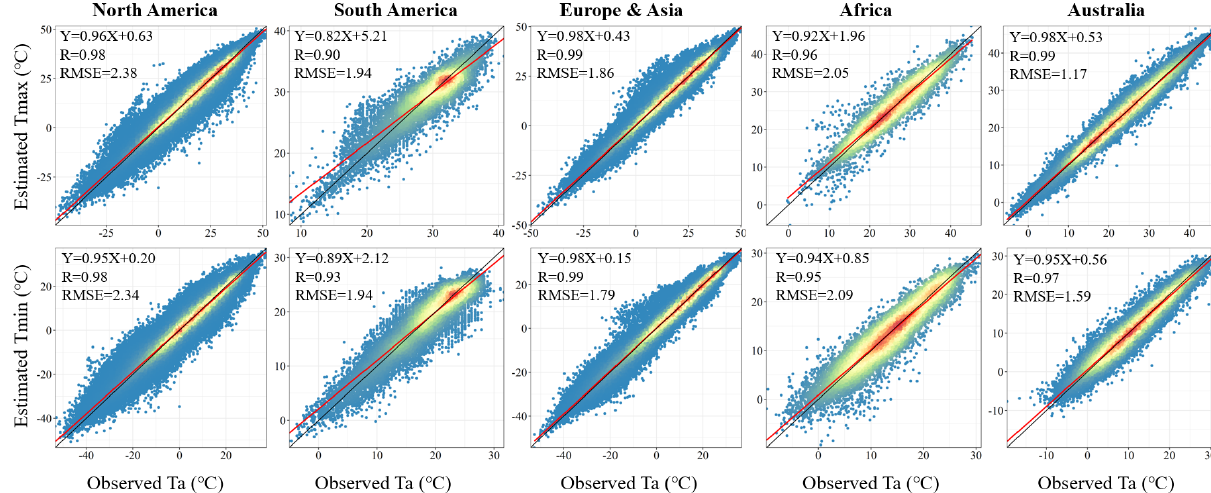
Figure 3. Scatter plots between estimated and observed T a in five regions in the year 2010. Each point represents the estimated and observed T a ( T max or T min ) on a specific day at a weather station. The color of points represents the density, in which red and blue points represent the high and low densities, respectively. The red line is the regression line, and the black line is the 1 : 1 line.